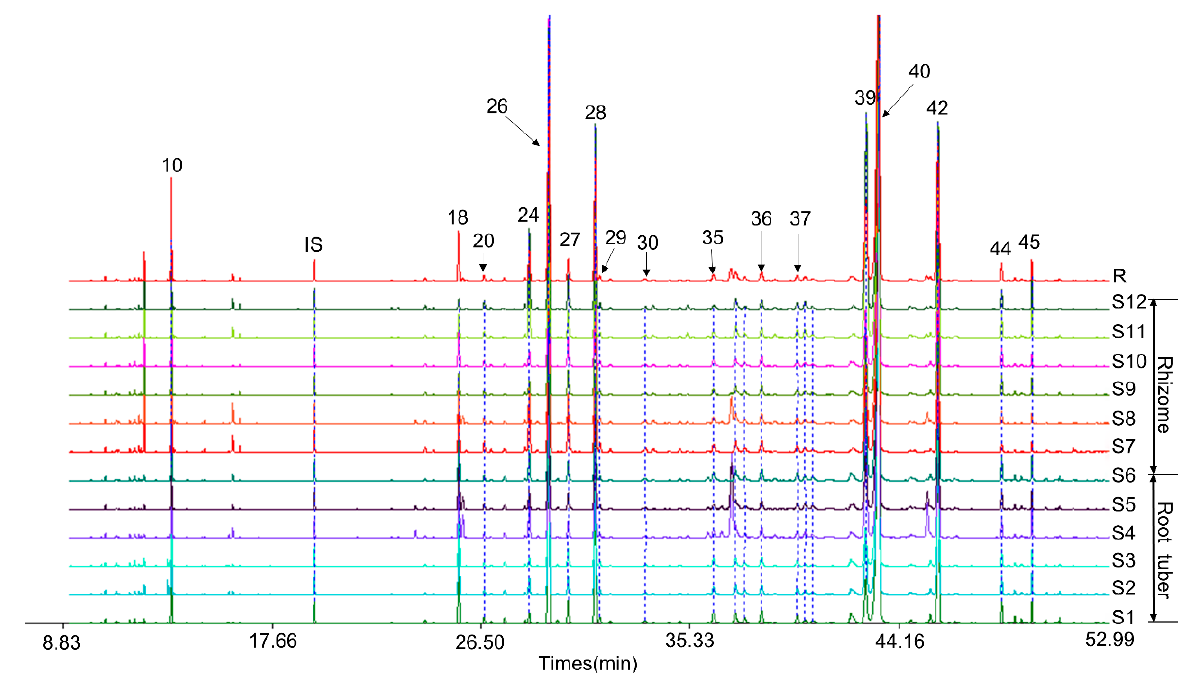
Figure 3. The GC–MS fingerprints of RCL and RHCL volatile oils. Chromatograms S1–S6 represented RCL volatile oils, whereas S7–S12 represented RHCL volatile oils. R was the reference chromatogram. Peak IS was the internal standard ( N -tridecane). Peaks 10, 18, 20, 24, 26, 27, 28, 29, 30, 35, 36, 37, 39, 40, 42, 44, and 45 were seventeen common peaks. Table 3. The chromatographic similarities with GC–MS fingerprints for RCL and RHCL volatile